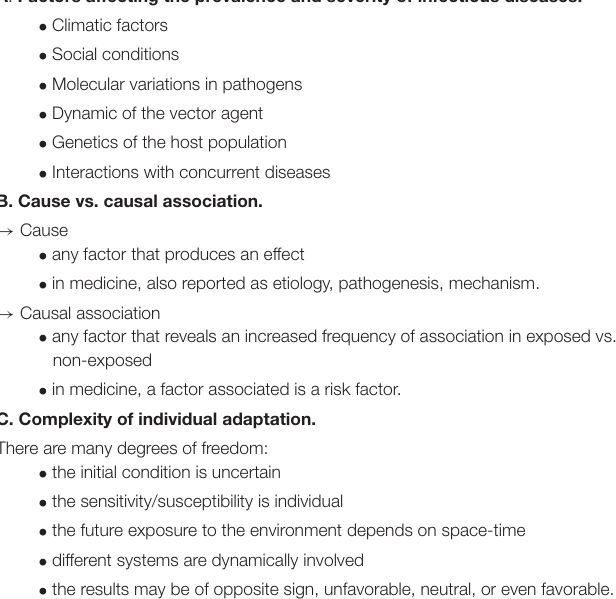
TABLE 1 | Prevalence, causation, and complexity of diseases. A . Factors affecting the prevalence and severity of infectious